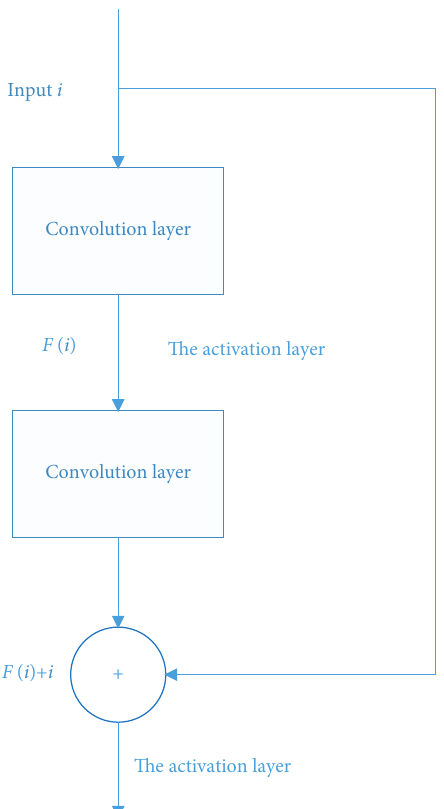
Figure 1: The residual network